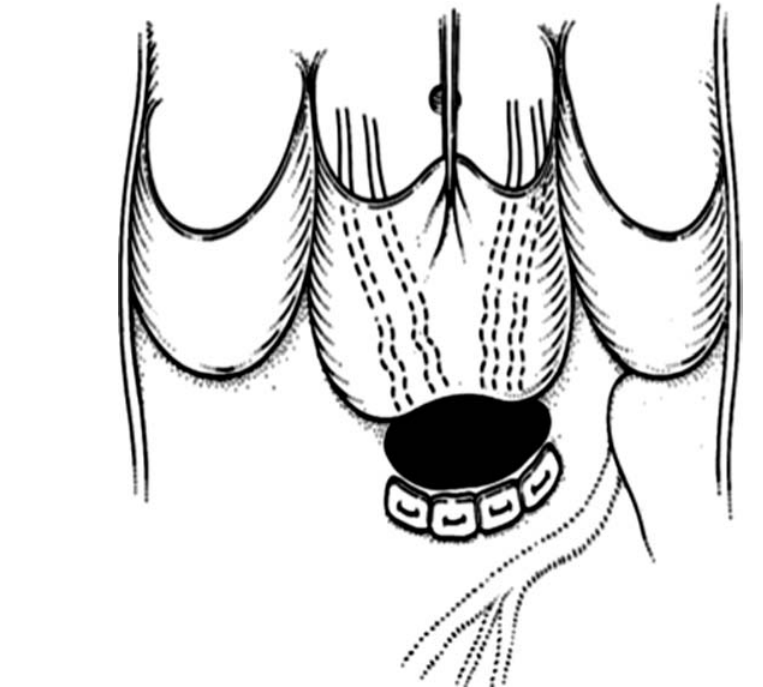
Figure 5. Cartoon depicting interrupted pledgeted sutures taken through the ventricular septal crest and into the right coronary cuspas placating sutures before finally being tied down in the right coronary sinus. (With permission J Thorac Cardiovasc Surg